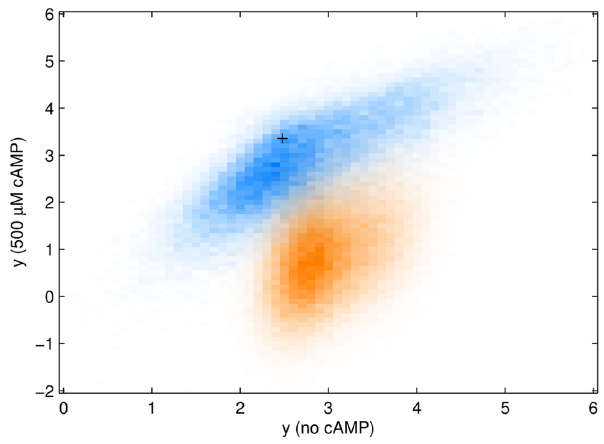
Figure 5. 2D histogram of expression for the two environ- ments, no cAMP (glucose), and cAMP (no glucose) for 10 5 random sequences (orange), and sequences from the experi- ment (blue), which are closer to the wild type (plus sign). The wild-type is nearly on the optimal front in that very few sequences have both higher expression with cAMP and lower expression without cAMP (above and to the left of the plus sign). The phenotype values range from 1 to 5 in these experiments. The dis-similarity of measured expression and expressions predicted for random sequences along the vertical, but not the horizontal axis, likely signals presence of poorly understood biophysical mechanisms differentially employed in the two considered